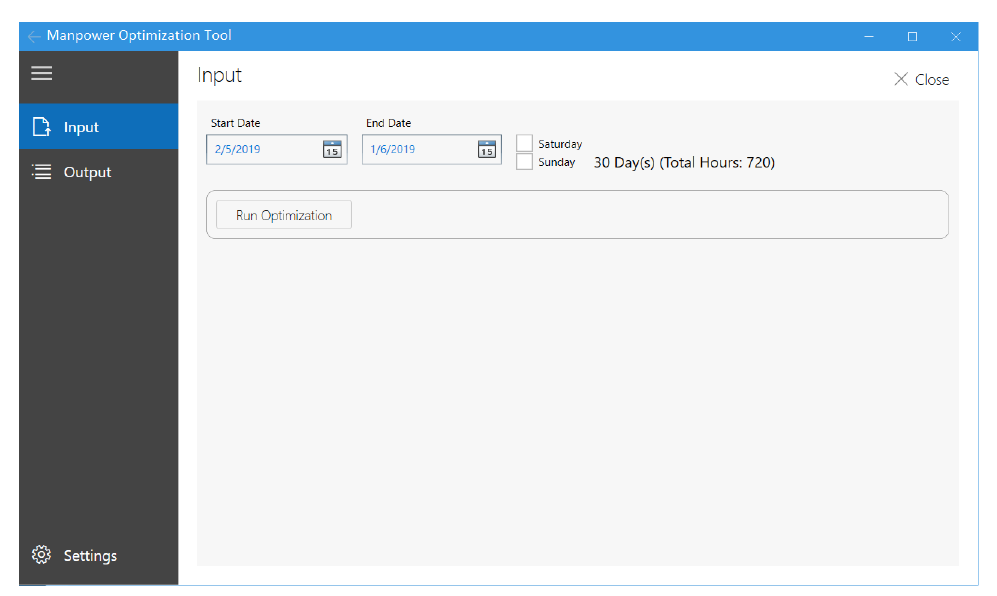
Figure 4. The GUI of the manpower allocation